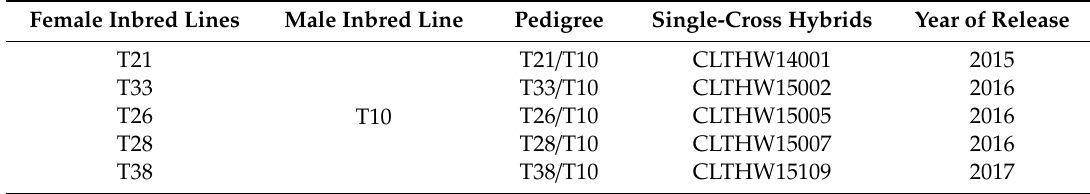
Table 1. Parental lines, their single cross hybrids, and year of evaluation in the MasAgro Network. Female Inbred Lines Male Inbred Line Pedigree